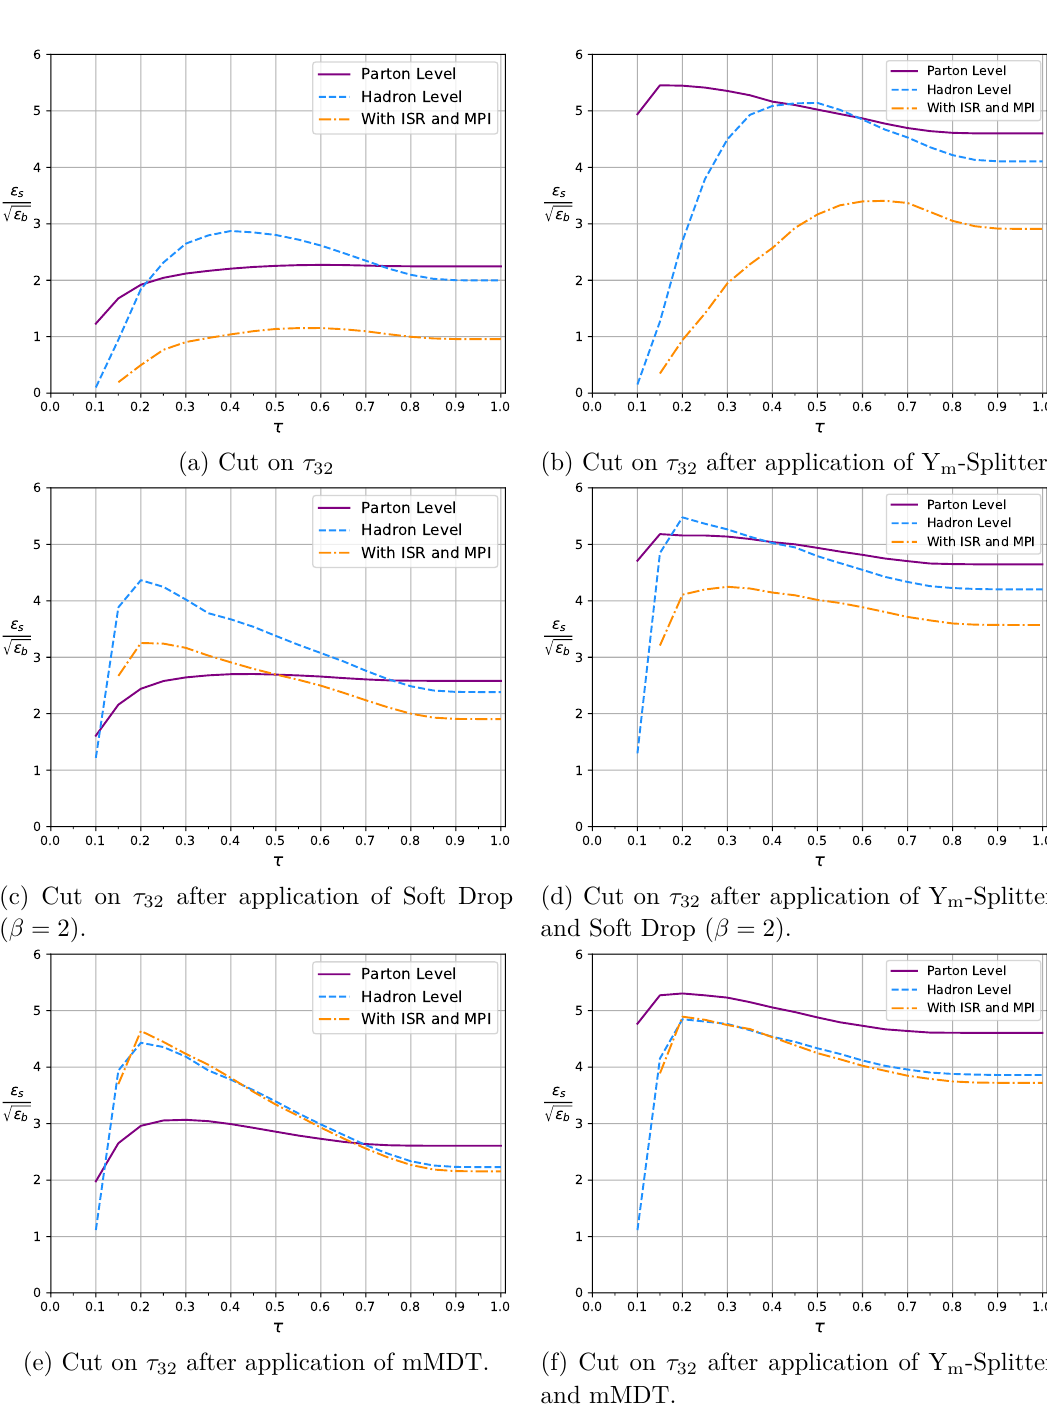
Figure 1. Plots showing the signal to square-root background of the four variants of the tagging procedure at parton level, hadron level, and with ISR and MPI activated at hadron